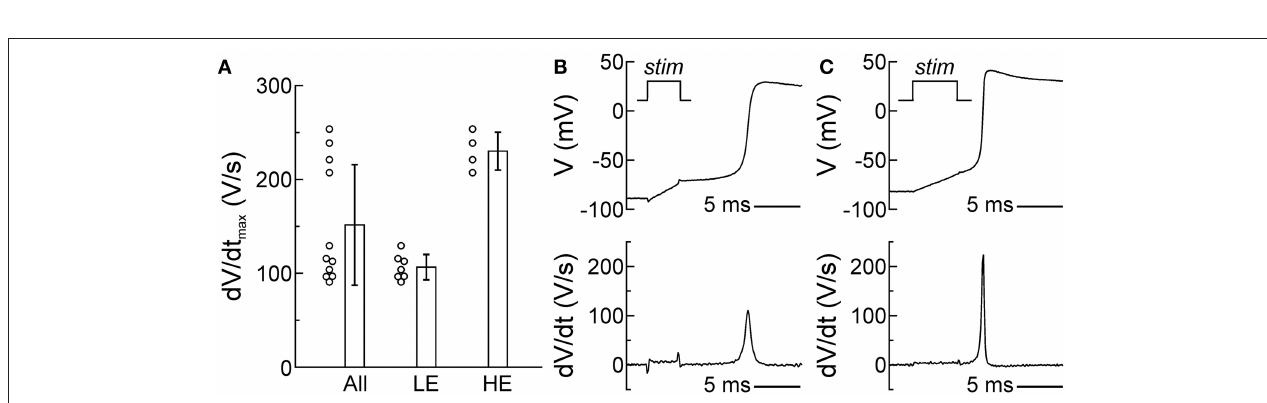
FIGURE 4 | Two subpopulations of SCMs with distinct levels of excitability. (A) Distribution of dV/dt max of all cells (left, n = 11 ). The distribution was bimodal and poorly reflected by its mean ± SD, revealing two subpopulations with different levels of excitability (middle: low excitability; right: high excitability). (B , C) Example AP upstrokes and dV/dt in a cell with low (B) and high excitability (C) . The stimulation pulse ( stim ) of the current clamp is indicated in the upper panels and corresponds temporally with the stimulation artifacts in the voltage traces and the calculated derivatives.